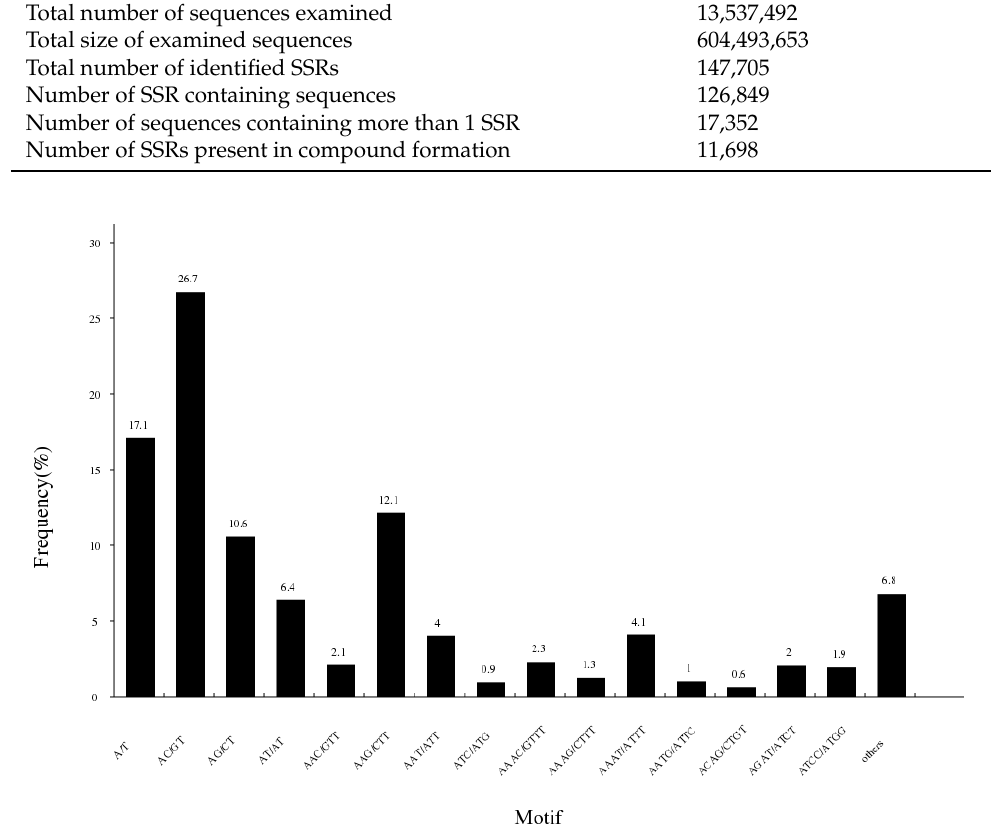
Table 6. The messages of 6 working SSR primer pairs from 10 synthesized primers.